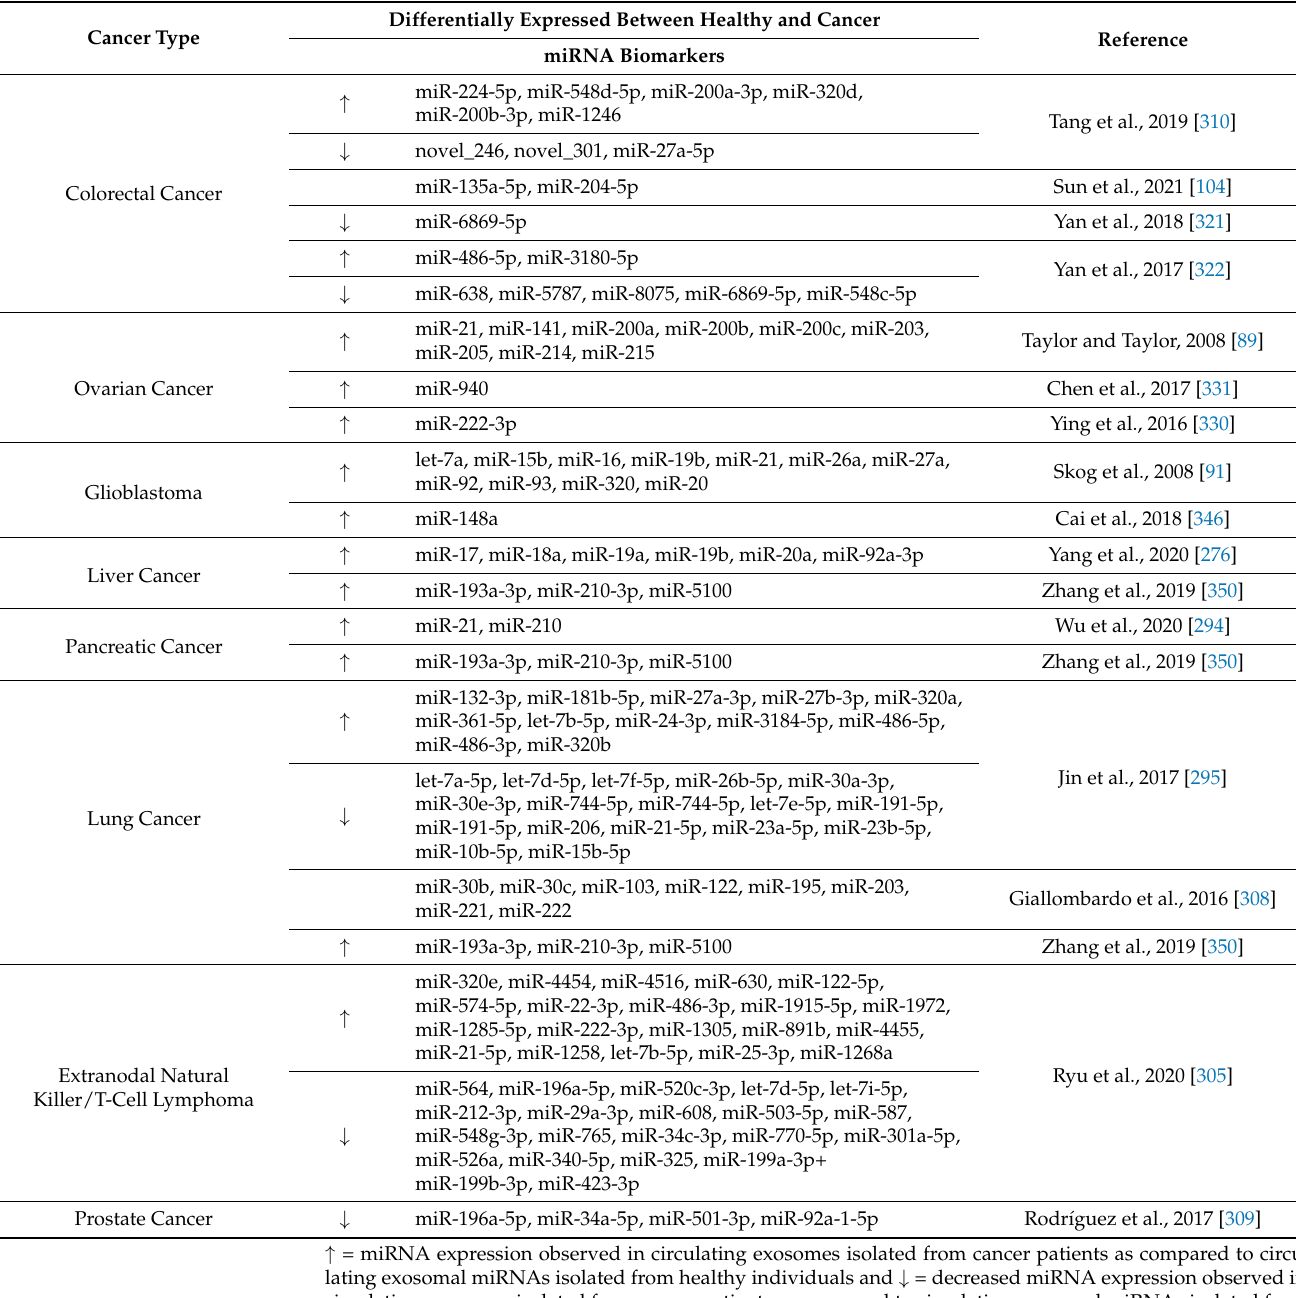
Table 1. Published miRNA exosome cancer biomarkers identified in human biofluids. Lists of exosomal miRNAs circulating in biofluids of patients diagnosed with colorectal cancer, ovarian cancer, Glioblastoma, liver cancer, pancreatic cancer, lung cancer, extranodal natural killer/T-cell lymphoma, and prostate cancers.